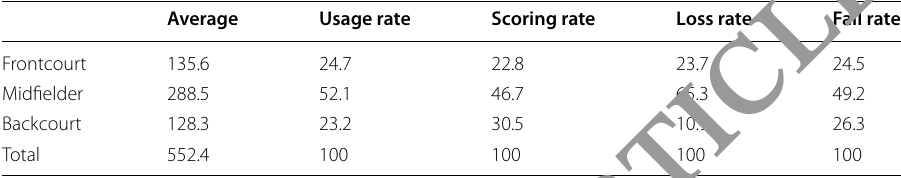
Table 4 Analysis of the characteristics of the five pairs of combined full-field tactics